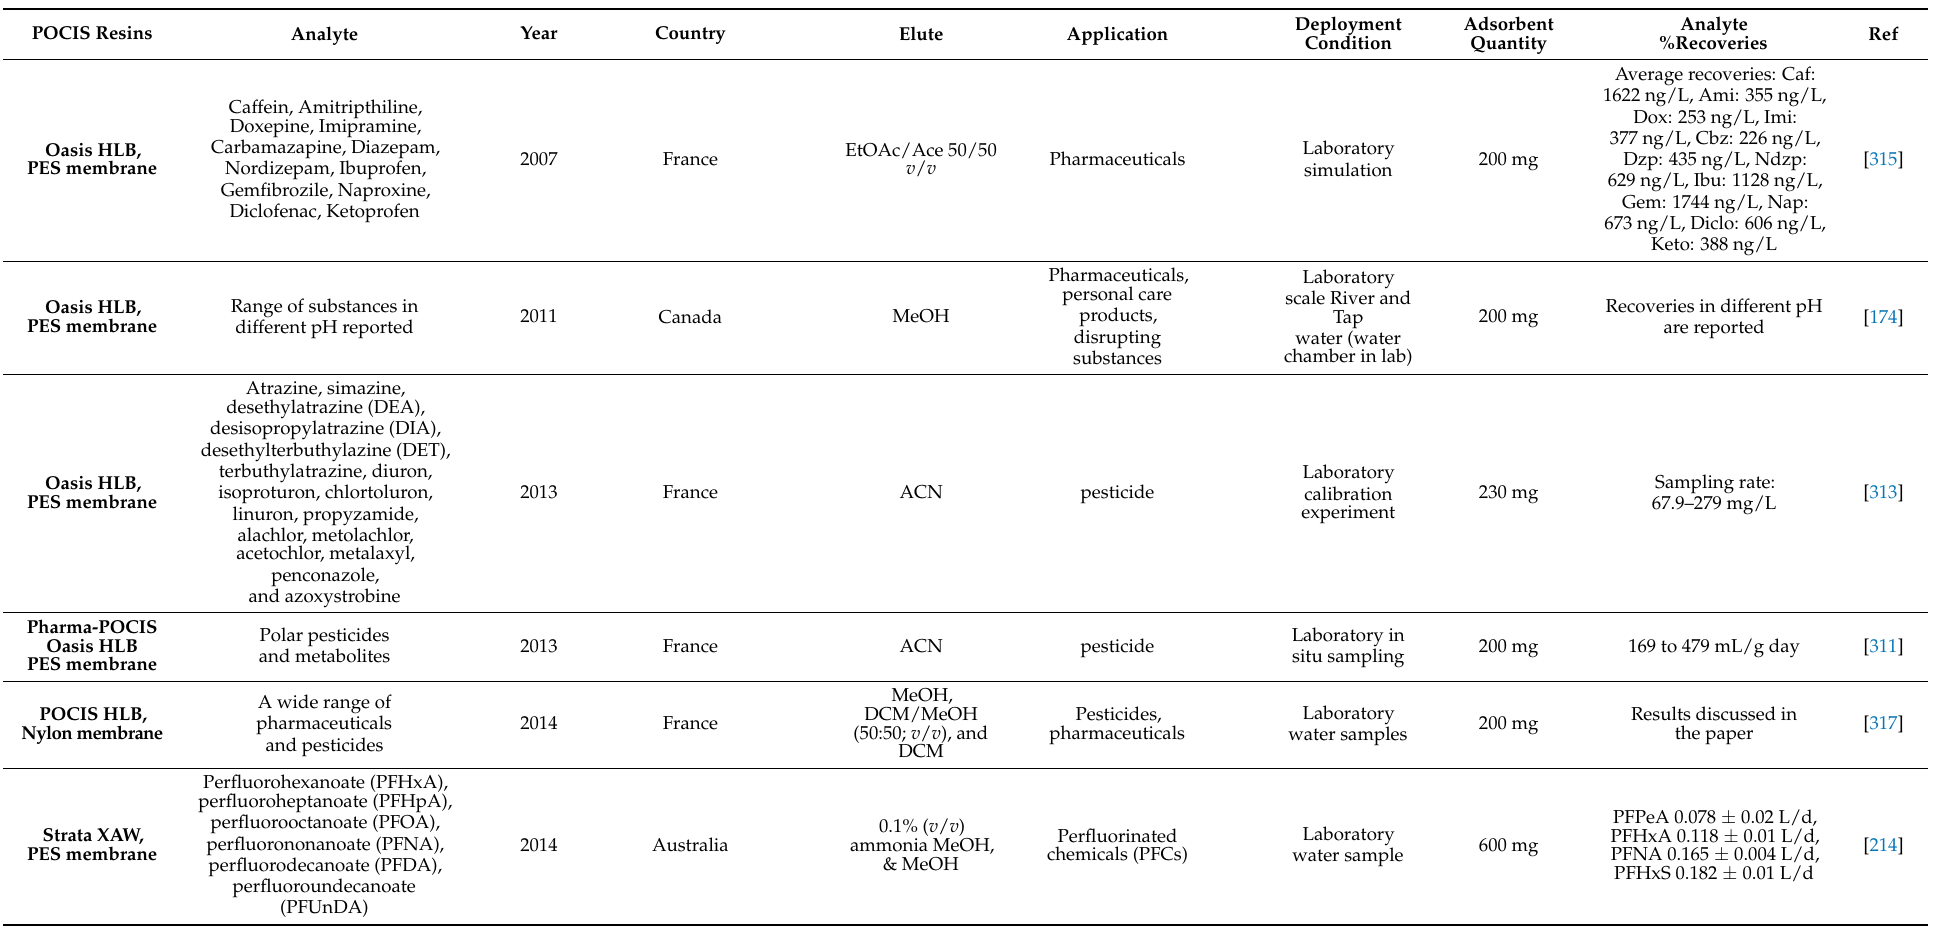
Table 11. Application of POCIS, in vitro laboratory